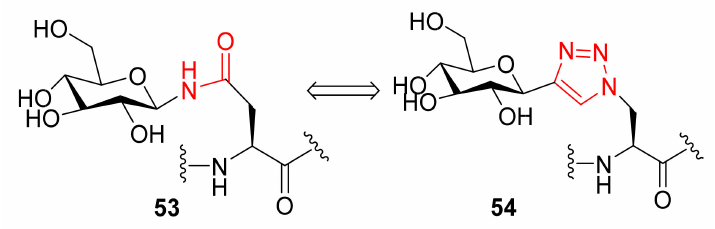
Figure 21. Triazole glycopeptide mimetics.